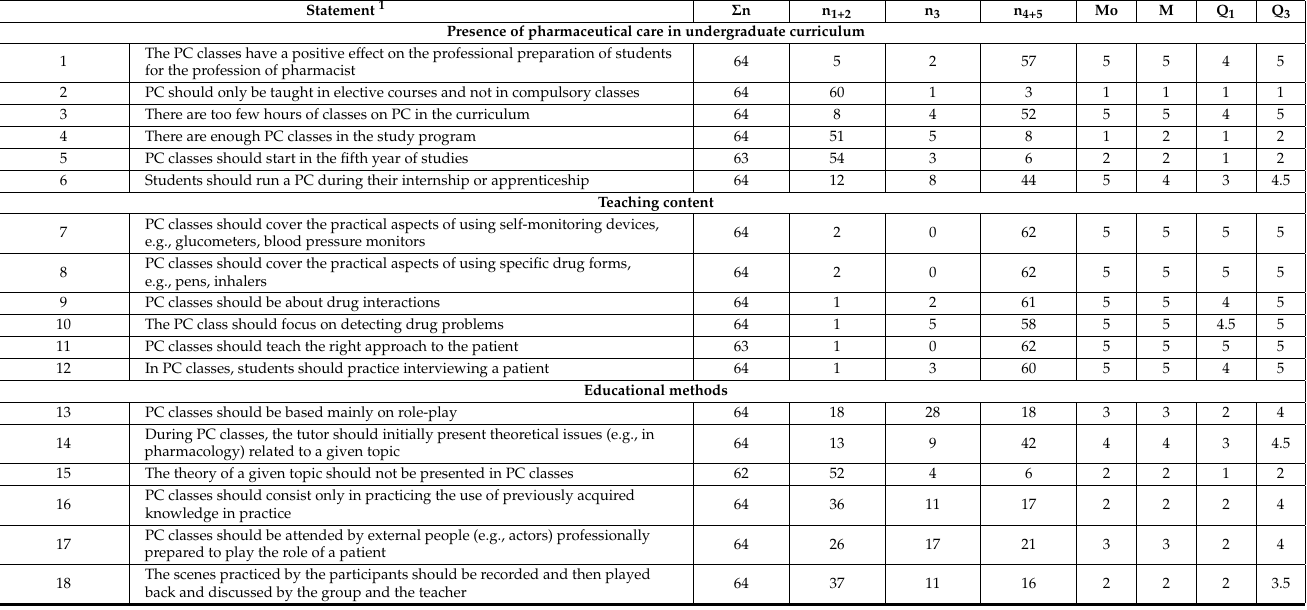
Table 3. Students’ attitudes toward teaching and learning pharmaceutical care during the undergrad- uate pharmacy program.